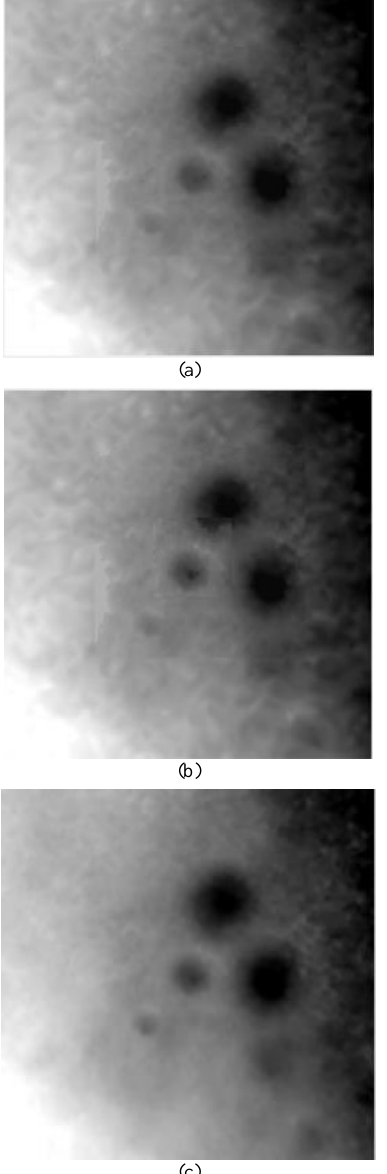
Figure 6. The reconstruction results of bilinear, kriging interpolation, and the proposed method.